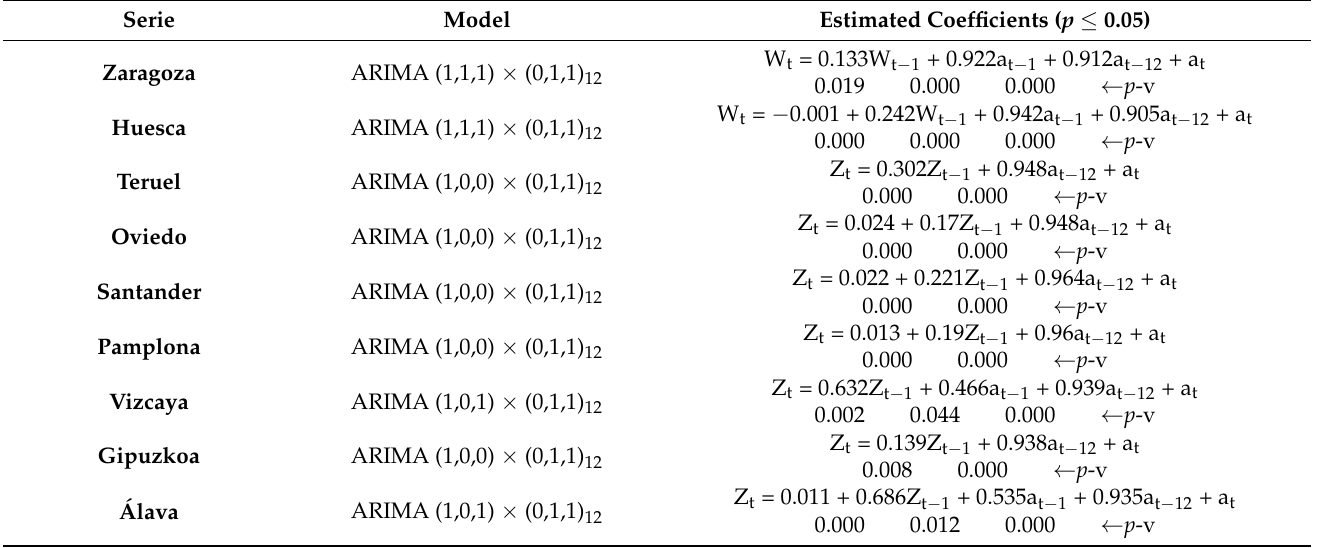
Table 4. ARIMA models of the 29 temperature series of peninsular